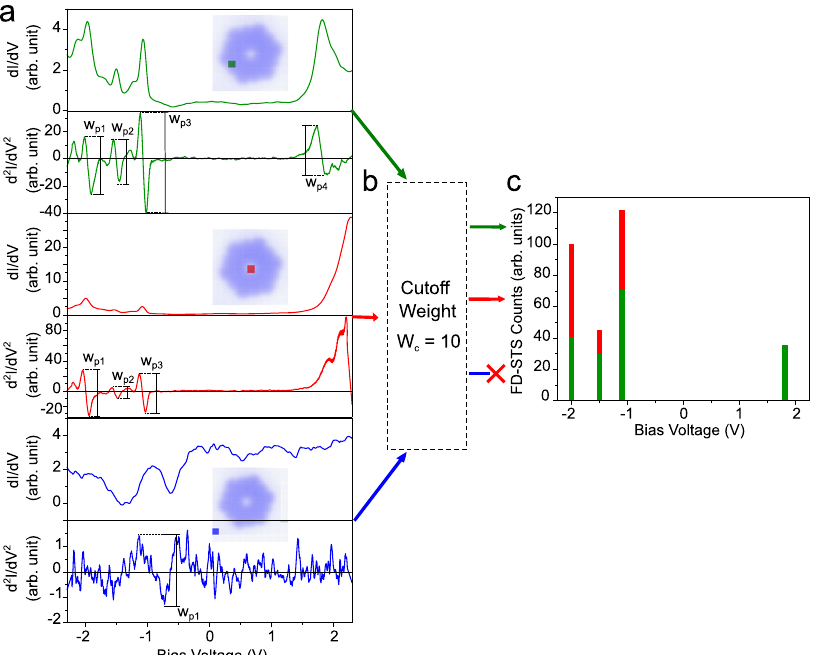
Fig. 5 Schematic representation of FD-STS algorithm. a d I /d V and d 2 I /d V 2 spectra for different positions (edge of the molecule, center of the molecule, and outside the molecule). b Schematic representation of the criterion to either collect or discard a given feature according to its weight. c Weighted histogram for the fi ltered features that passed the cutoff